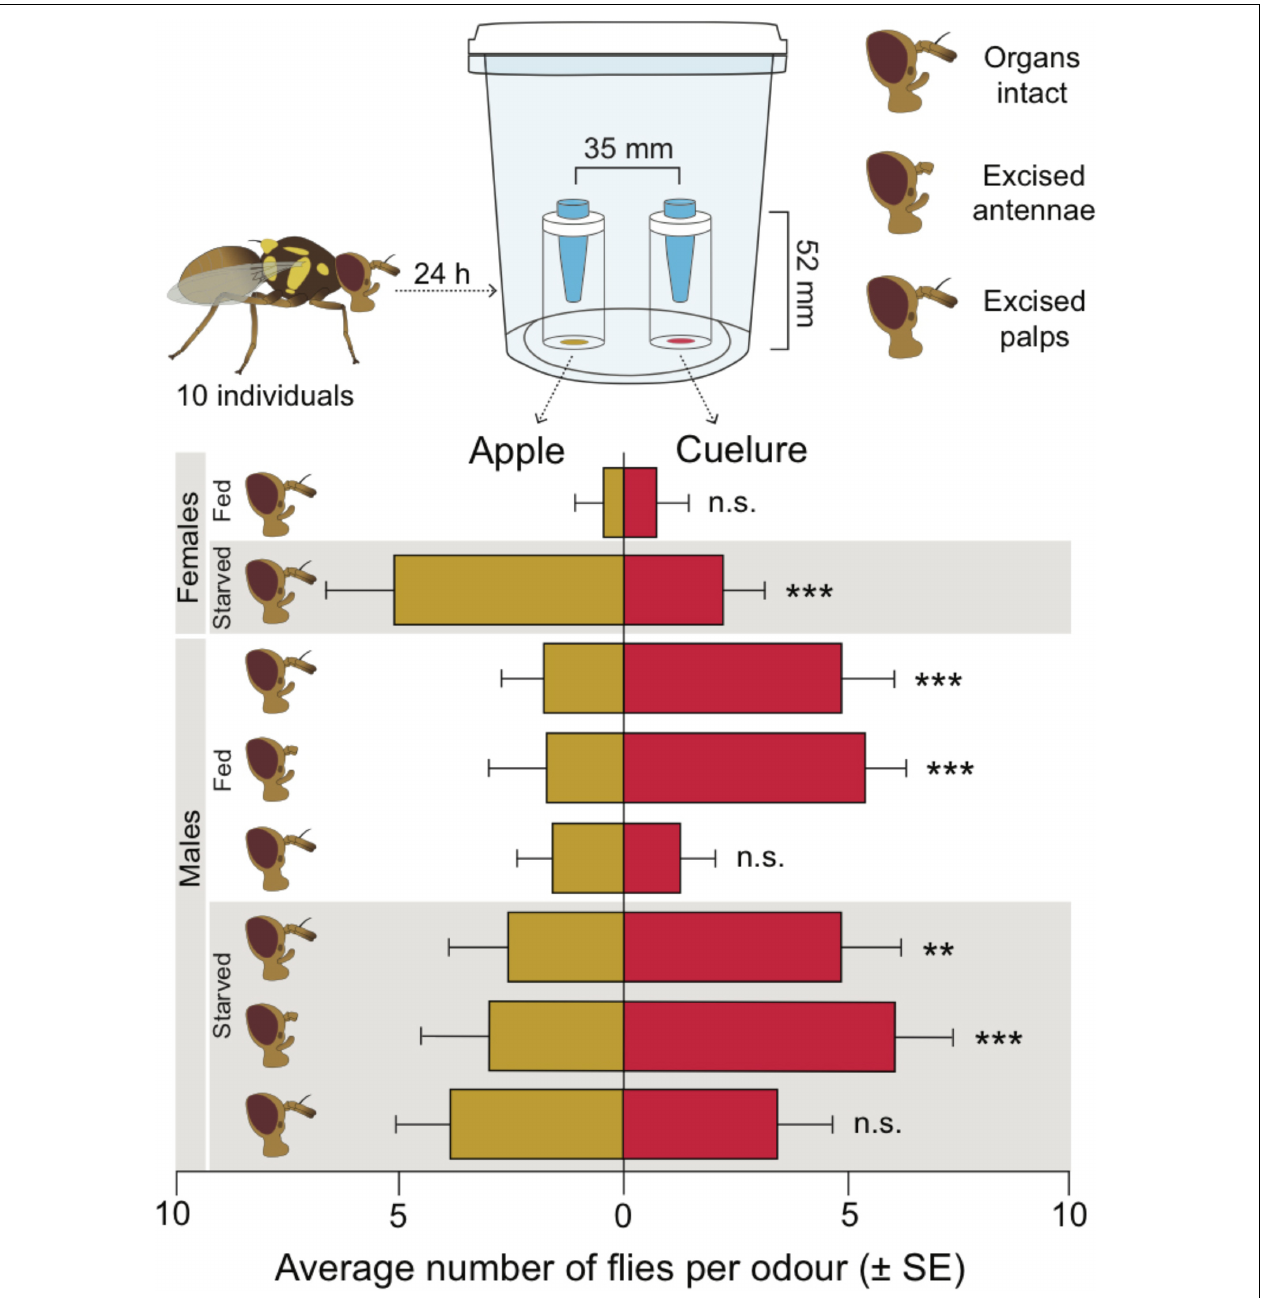
FIGURE 1 | Number of trapped female and male Bactrocera tryoni in the two-choice trap assay containing apple juice (yellow) and cuelure (red). A graphic representation of the trap assay and the different options of excised sensory organs is given at the top of the figure. The number of flies trapped in apple juice or cuelure is illustrated with their mean and standard error. n.s., not significant; ∗∗ P < 0.01 and ∗∗∗ P < 0.001. Each treatment consists of 15 trials with 10 flies in